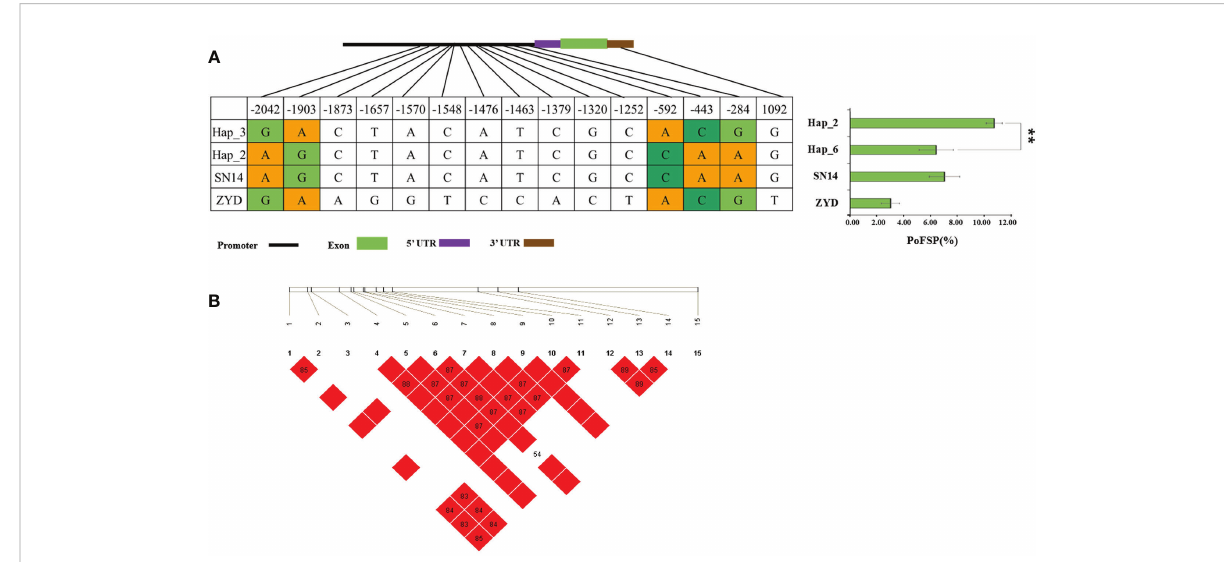
FIGURE 9 Haplotype analysis results of Glyma.13G126300. (A) : Correlation analysis of the major haplotype phenotype in Glyma.13G126300. (B) : LD analysis of SNPs among major haplotypes of Glyma.13G126300 . a : “ ** ” indicates a signi fi cant difference at the 0.01